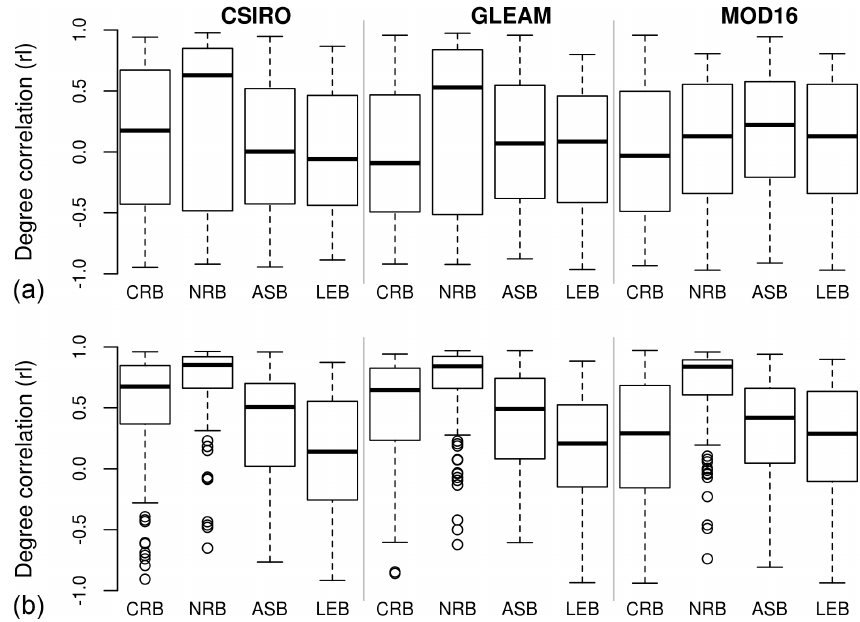
Figure 8. Top: average degree correlation statistics per study region and evaporation product. Bottom: GRACE data were shifted by 2 months to match the phase with P − E anomalies. The boxplots show the first, second (median), and third quartiles. Outliers, defined as data outside the 1.5 inter-quartile range (IQR) whiskers below or above the first and third quartiles, are shown as